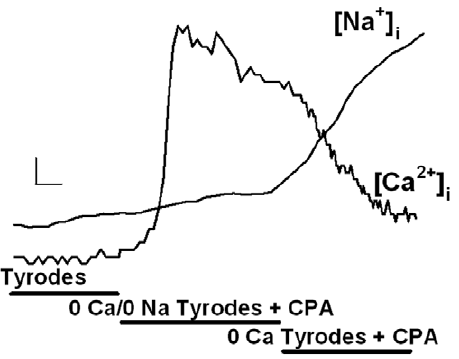
Figure 7. Evaluation of outward exchange mode NCX in human ASM cells using measurement of [Ca 2 + ] i (fura-2) vs. [Na + ] i (SBFI). Inhibition of SR Ca 2 + reuptake using CPA in the absence of extracellular Ca 2 + or Na + (thus inhibiting NCX) resulted in increased [Ca 2 + ] i levels (with only small changes in [Na + ] i levels). Rapid re- introduction of extracellular Na + resulted in activation of outward exchange-mode NCX, thus decreasing [Ca 2 + ] i while increasing [Na + ] i . Horizontal scale bar is 10 s. Vertical scale bar is 50 nM for Ca 2 + and 2 mM for Na + .